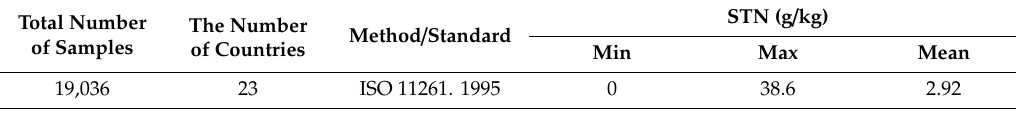
Table 1. Description of the Land Use / Cover Area Frame Statistical Survey (LUCAS) Soil